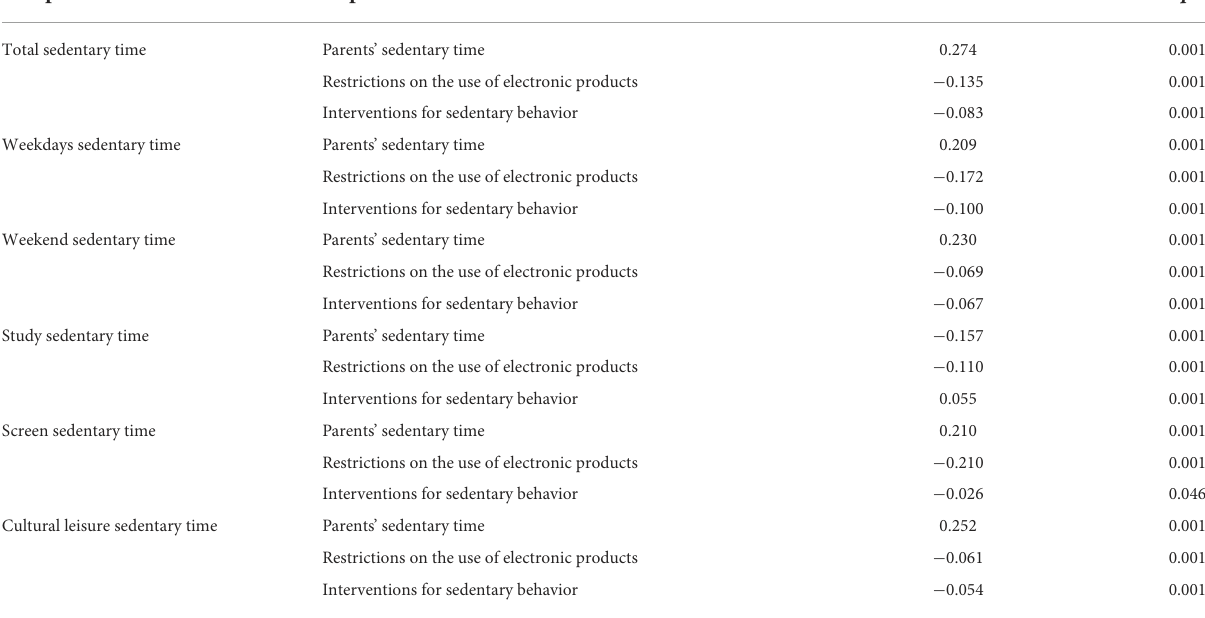
TABLE 10 Correlation analysis of sedentary behavior in children and